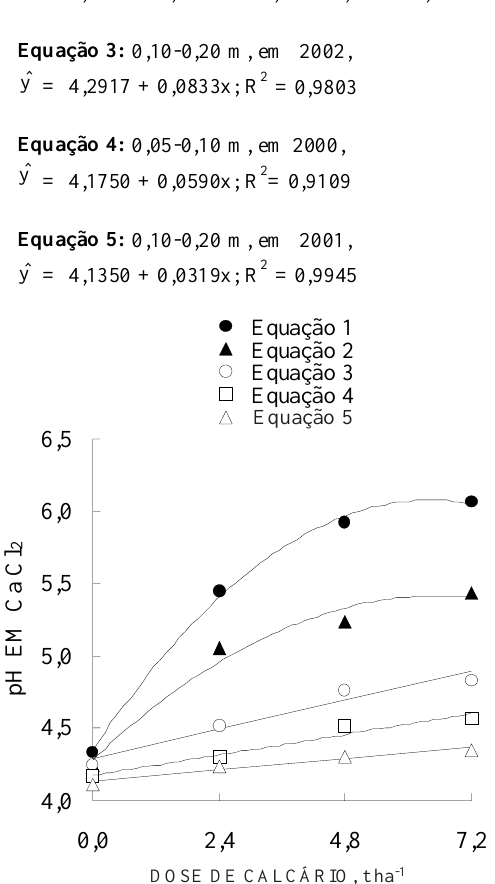
Figura 3. Valores de pH em CaCl de acordo com as 2 doses crescentes de calcário distribuído na su- perfície do solo em 1999. As equações de regres- sões (linear e quadrática) variam de acordo com as camadas de solo (0,05–0,10 e 0,10–0,20 m) e anos de amostragem (2000, 2001 e